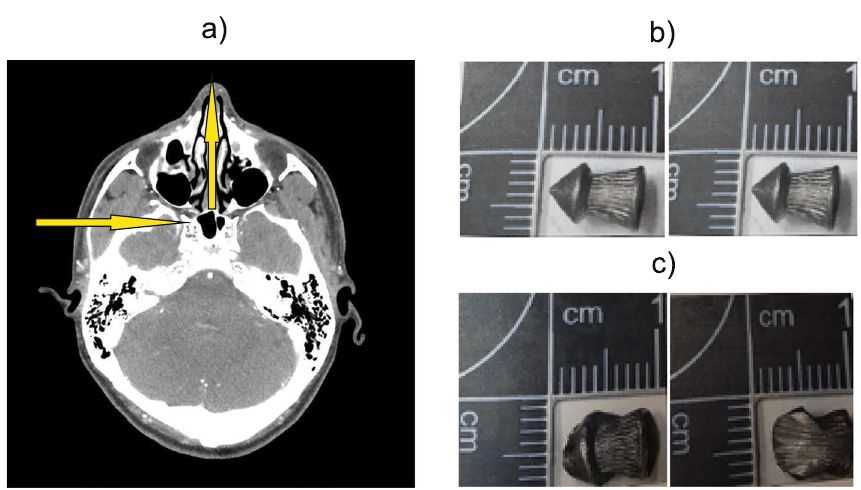
Fig. 4 Diabolo pellet a schematic representation of “route” using an example CT scan (cranial cavity retrieved from the patient (two side views): c pellet from the skull and from the